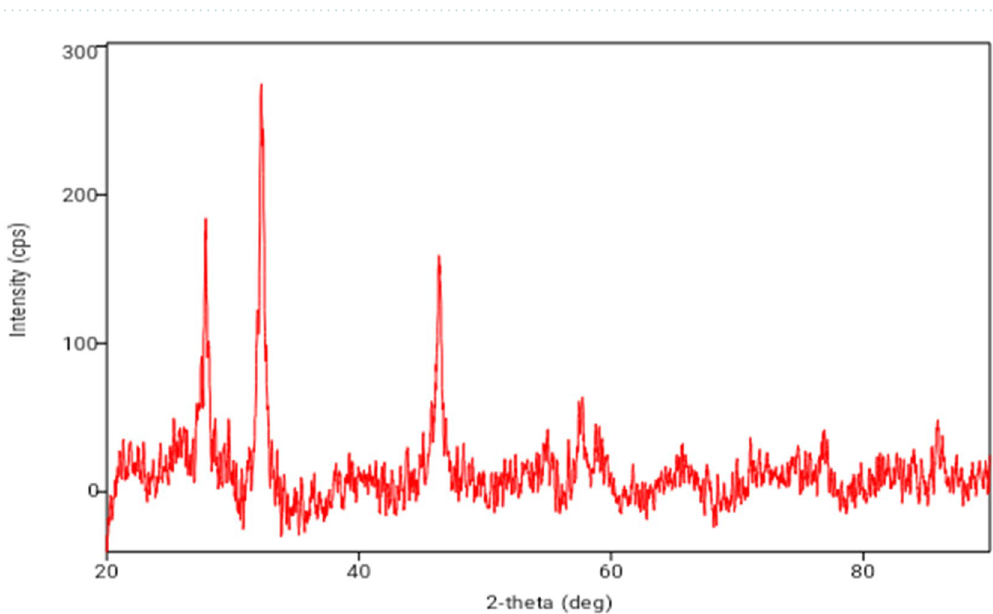
Figure 5. XRD pattern of the sardine fish scales fabricated silver